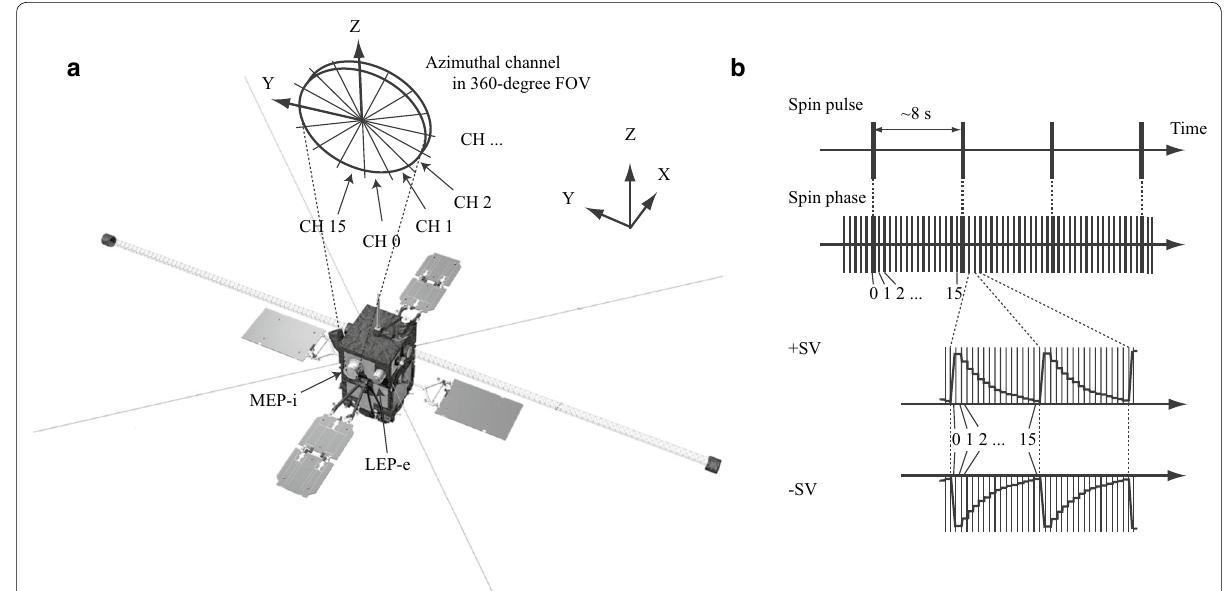
Fig. 2 a Mounting position of the MEP-i on the ERG spacecraft, satellite coordinate system, and definition of the MEP-i azimuthal channels. b Observation sequence of the spin phase and ESA sweeping voltages of the